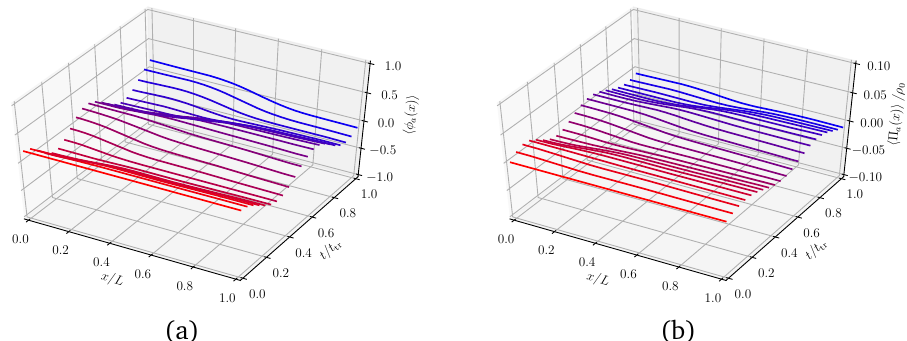
( x ) 〉 corresponding to the a